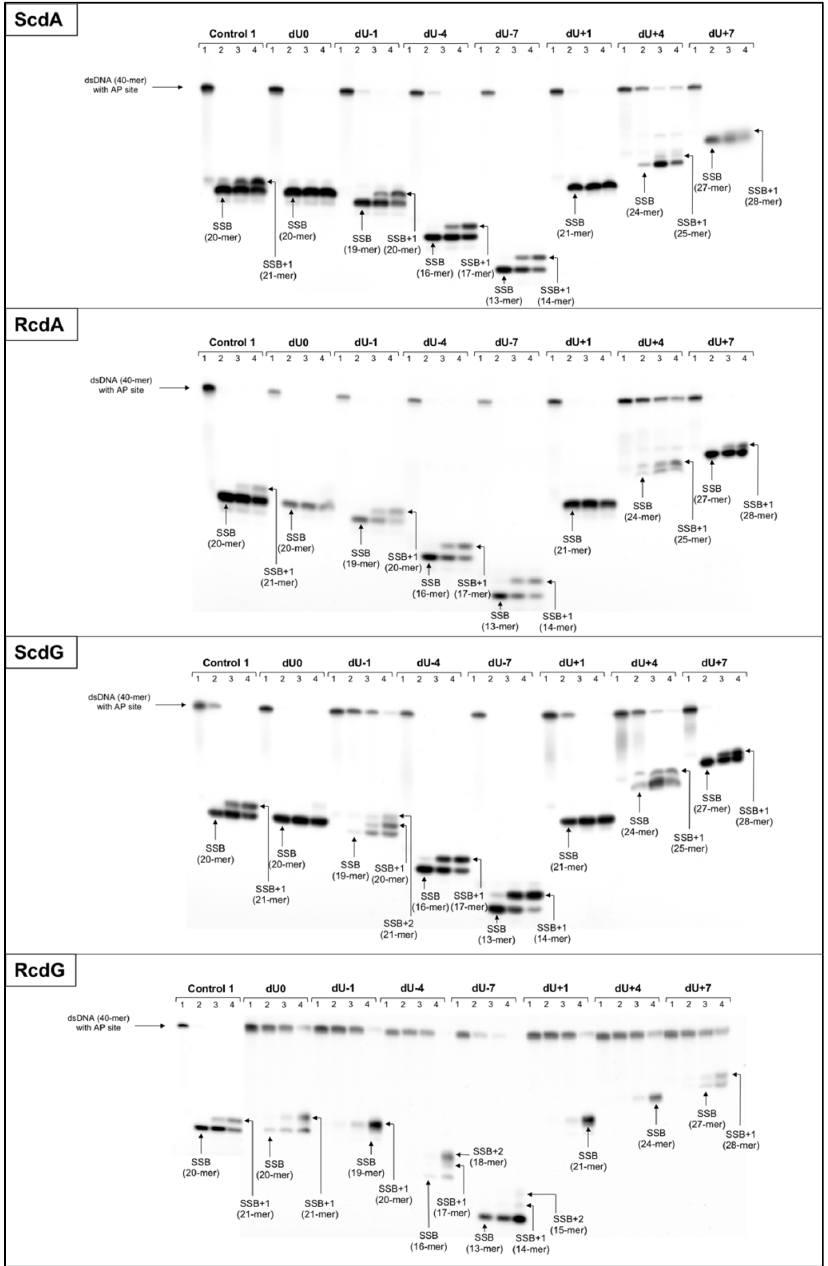
Figure 2. The representative autoradiograms of denaturing PAGE presenting the strand incision and elongation of dsDNA containing clustered damage with AP site on one strand (observed on the gel) and ScdA on the opposing strand (not observed on the gel). Control 1: dsDNA with a single AP site lesion on one strand; dU0: dsDNA with clustered lesions on two strands opposite to each other; negative numbers: dsDNA with clustered lesions on two strands where AP site is located 1–7 base pairs in 3 ′ -end direction; positive numbers: dsDNA with clustered lesions on two strands where AP site is located 1–7 base pairs in 5 ′ -end direction; SSB: dsDNA with single-strand break obtained after AP site incision (gap formation); SSB+1/SSB+2: dsDNA with single-strand break obtained after AP site incision (gap formation) and incorporation of 1 or 2 undamaged nucleotide units. Each lane corresponds to a different assay time: lane 1–0 h; lane 2–0.5 h; lane 3–3 h; lane 4–6 h. Each experiment was performed three times for consistency (individual replications and graphical representation of results with SD are available in Supplementary Materials).